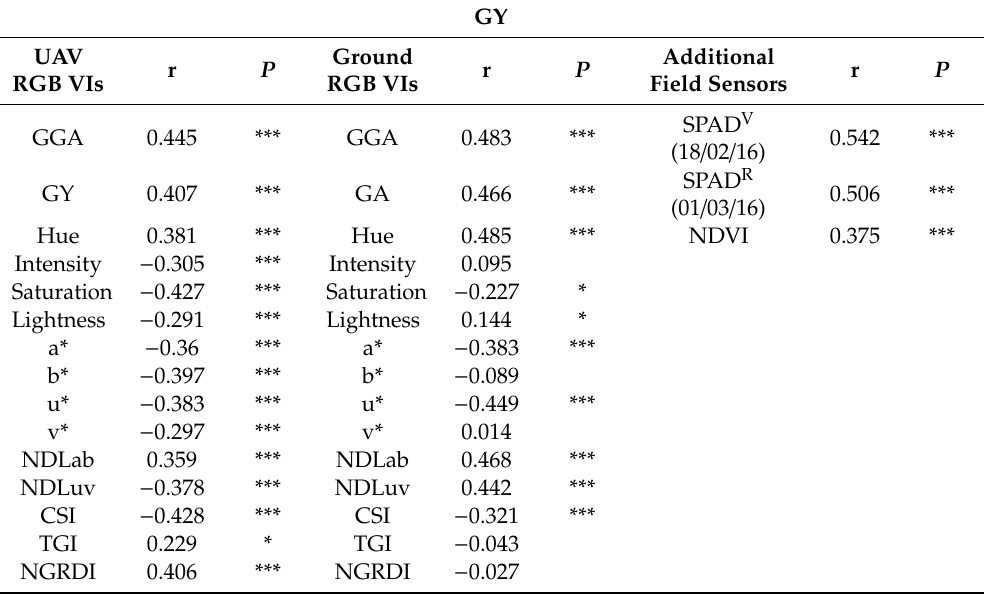
Table 3. Grain yield correlations in LOW with all proximal remote sensing variables from the RGB images taken from the UAV aerial platform, RGB images from the ground, and leaf chlorophyll content (SPAD) and normalized di ff erence vegetation index (NDVI) field sensors. These indices are defined in Sections 1 and 2. Levels of significance: *, P < 0.05; ***, P < 0.001. GGA; GA; NDLab, normalized di ff erence between a* and b*; NDLuv, the normalized di ff erence between u* and v*; CSI, crop senescence index; TGI, triangular greenness index; and NGRDI, normalized green–red di ff erence index. GY UAV